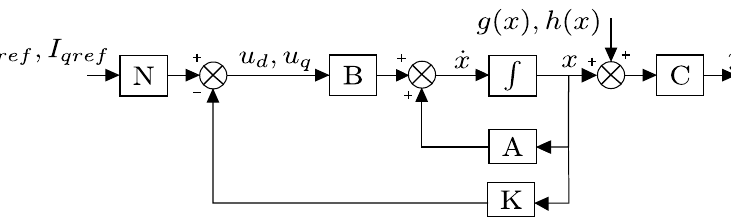
Figure 3. Full state feedback LQR-controller for the decoupled MG